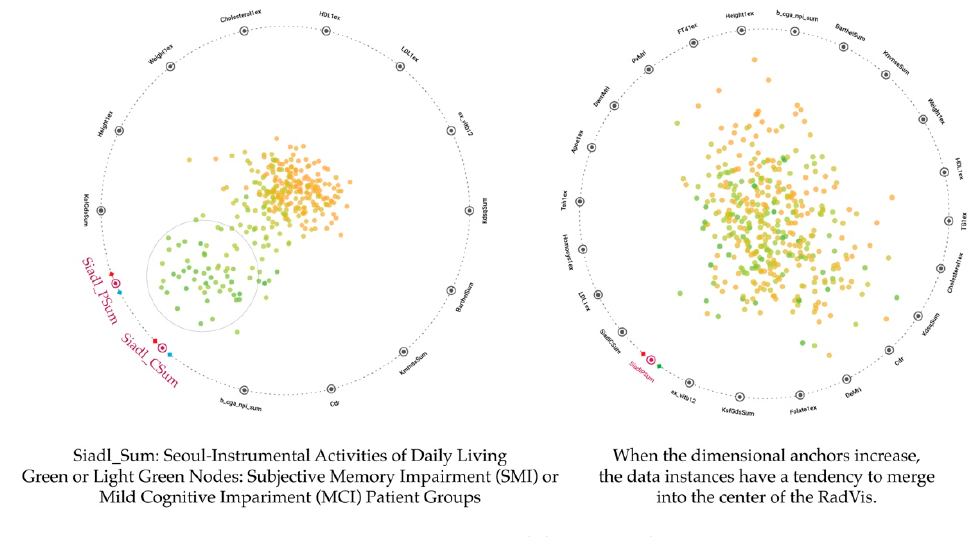
Figure 4. Previous model 2: 2D RadVis.